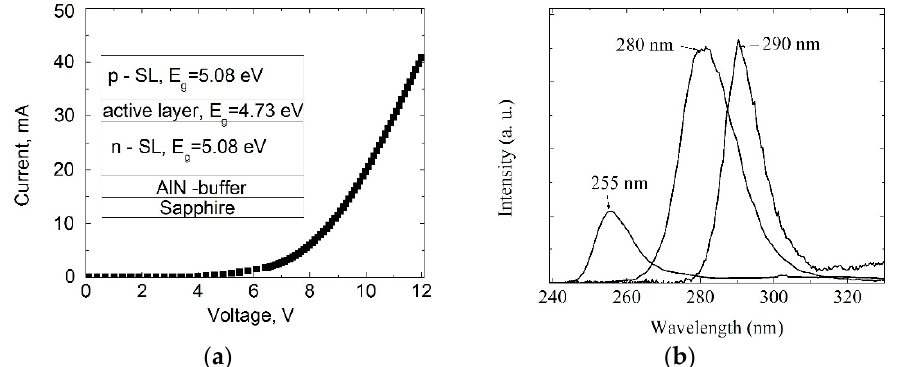
Figure 10. Electrical and optical characteristics of AlN/AlGa(In)N SPSL-based DHS mesa-LEDs. ( a ) Current–voltage characteristic of a typical LED operating at 262 nm wavelength. Note that light emission was observed with forward dc current above 2 mA; ( b ) Electroluminescence spectra of similar AlN/AlGa(In)N SPSL-based DHS mesa-LEDs operating at 255, 280, and 290 nm.